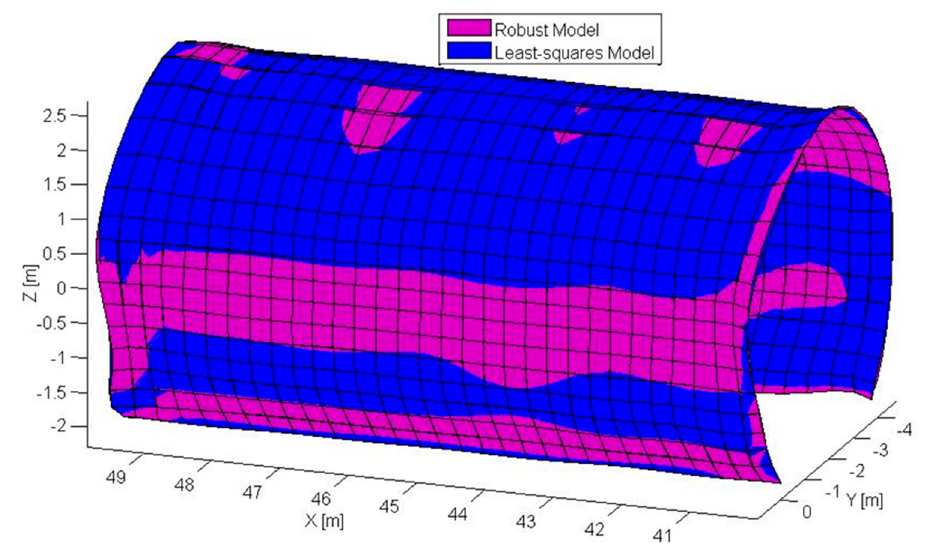
Figure 8. The robust 3D B-spline model for the tunnel.